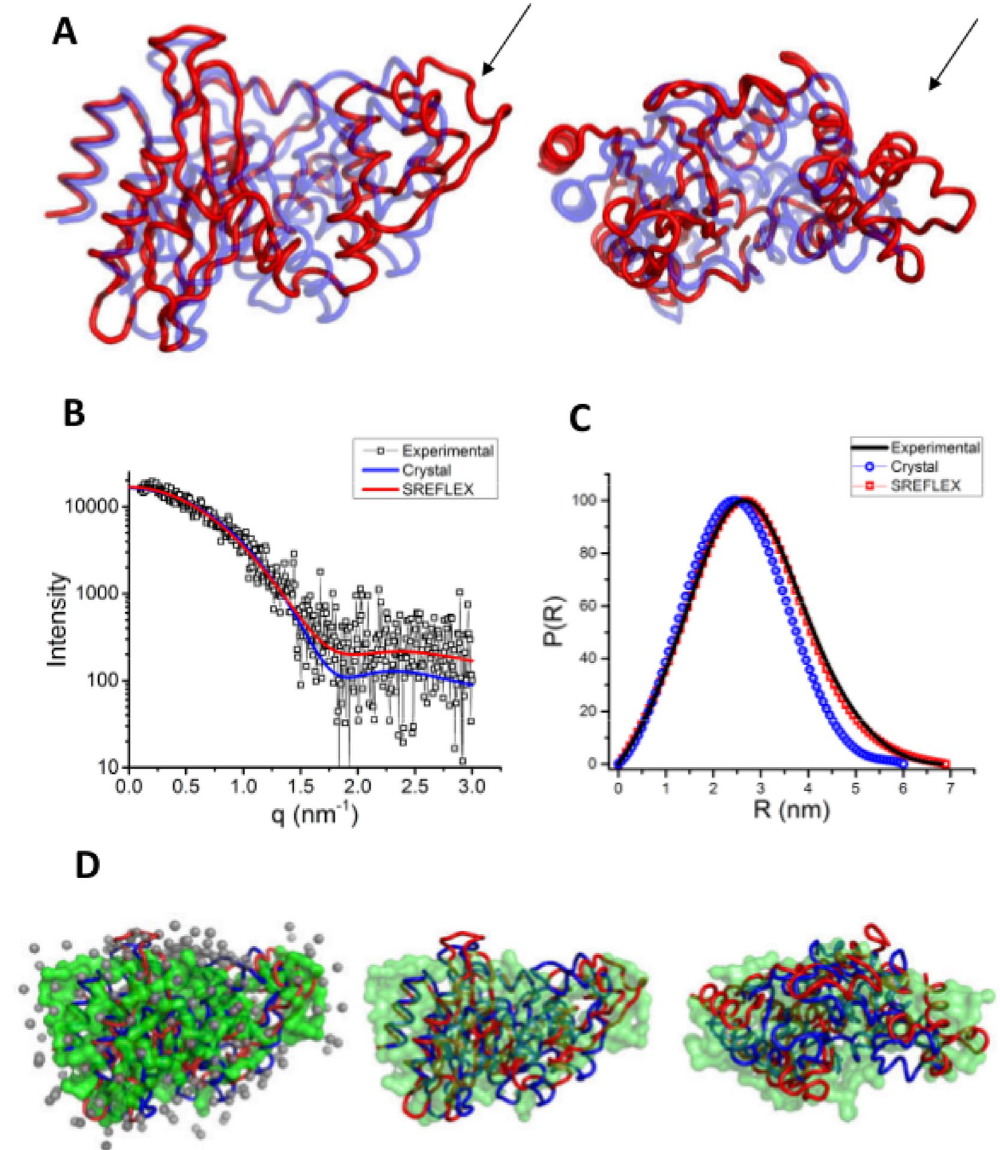
Figure 6. Using NMA and SAXS to derive the open model of BlaC. ( A ) The SREFLEX derived model and the crystal structure overlaid on each other. The loop showing the most prominent change is highlighted by a black arrow. ( B and C ) The fit between the theoretical SAXS profiles and distance distribution functions of closed form of BlaC, as seen in the crystal structures, and the open form derived by SREFLEX with the experimental data. ( D ) An overlay of the SAXS model of BlaC in Apo state with the crystal structure and SREFLEX derived model (Left), followed by two orthogonal views without the water